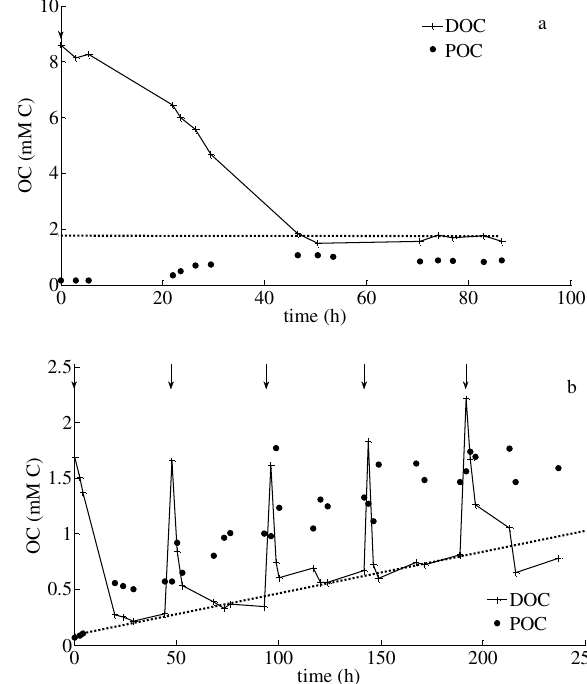
Fig. 1. Concentrations of dissolved and particulate organic carbon (DOC and POC, in mMC) measured in (a) the SA and (b) the P experiments. Arrows represent time when substrate was added to the cultures. DOC represents the substrate (pyruvate) plus all other DOC forms produced during the experiment, and POC represents the bacterial biomass. DOC dynamics are visualized by lines connecting the data points. Dotted lines = DOC accumulation throughout the experiment. OC is organic carbon.